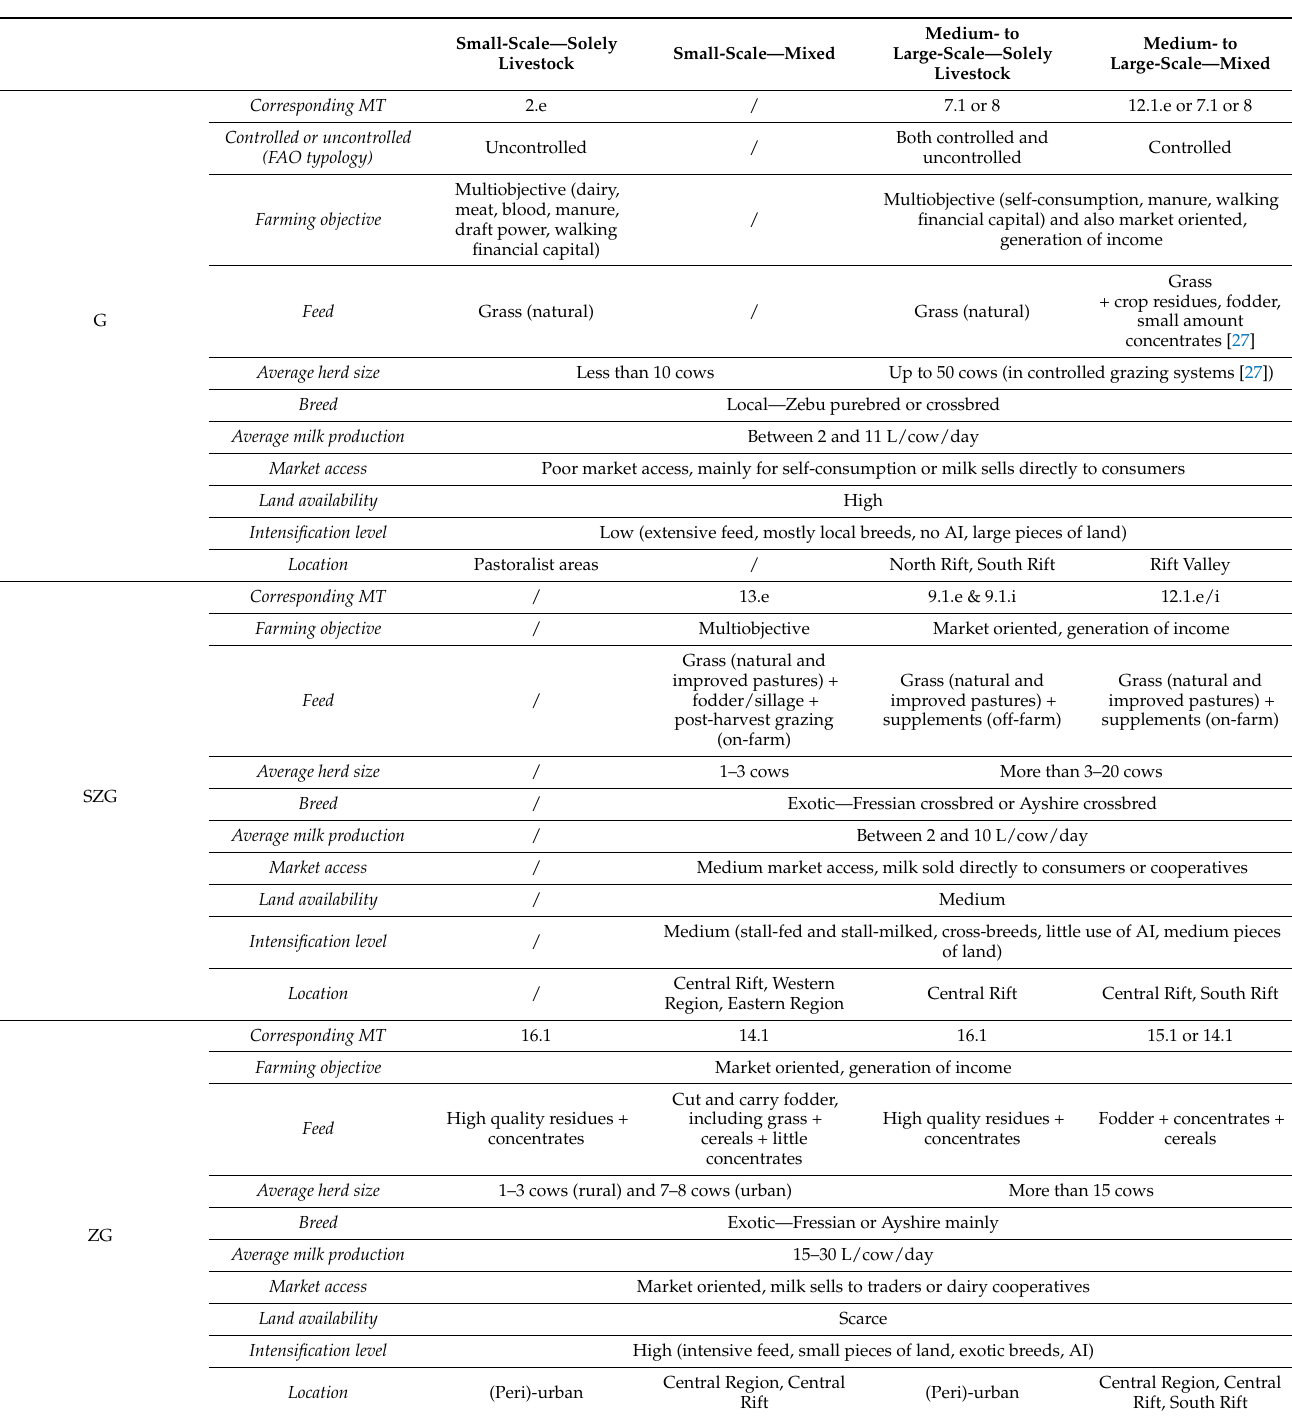
Table 1. Description of dairy production systems in Kenya [28,30,31,34,36], G = grazing; SZG = semi- zero-grazing, ZG = zero-grazing. Small-Scale—Solely Livestock